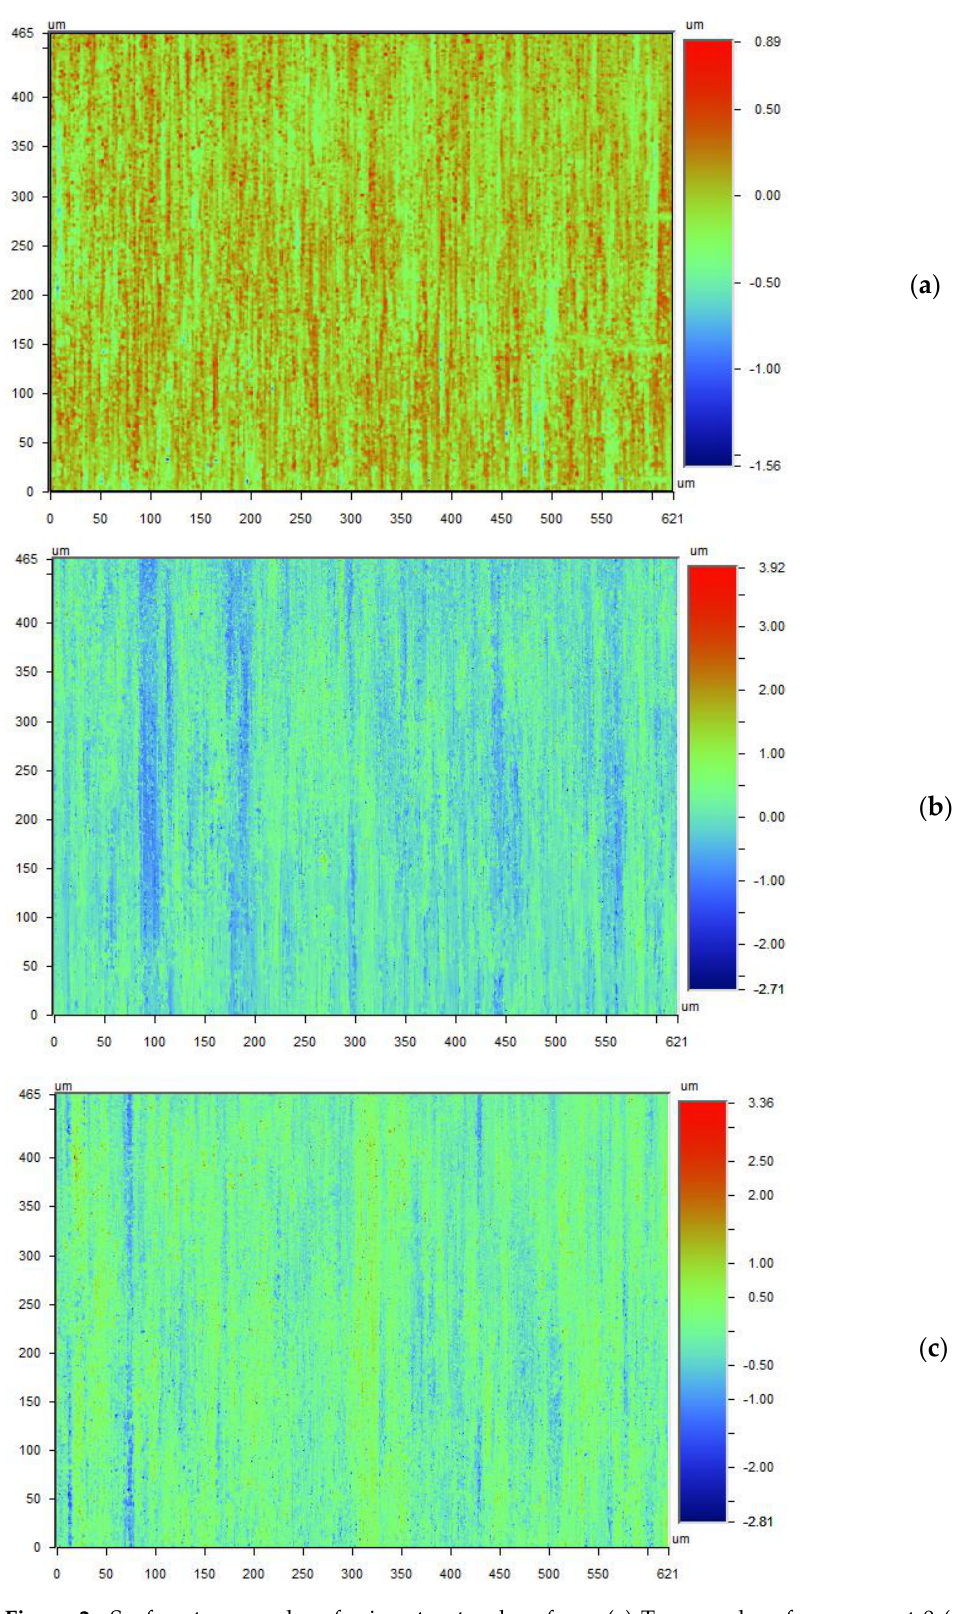
Figure 2. Surface topography of microstructural surface. ( a ) Topography of component 0 (pol- ished surface S a = 0.082 mm). ( b ) Topography of component 2 (textured surface S a = 0.263 mm). ( c ) Topography of component 3 (textured surface S a = 0.255 mm).